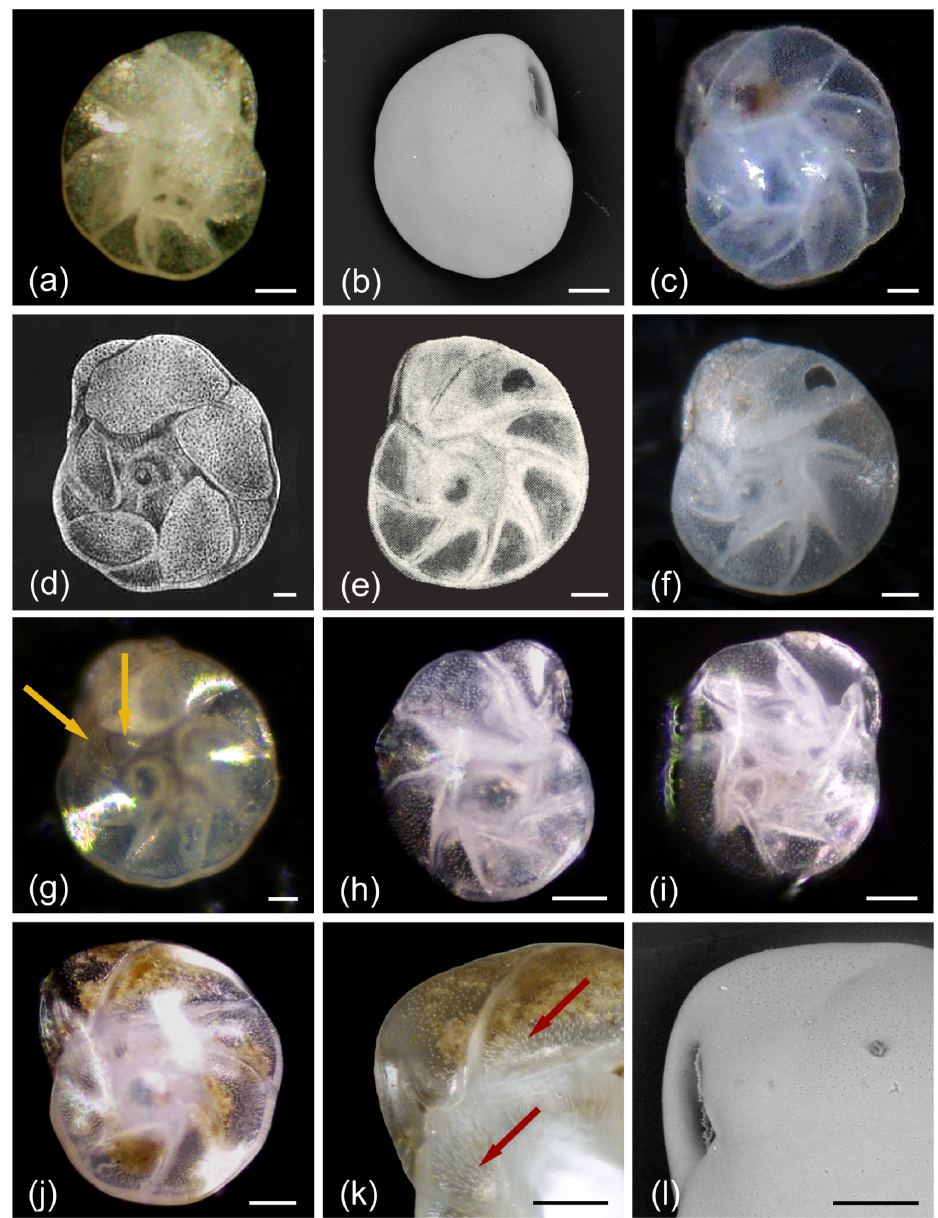
Figure 4. Islandiella helenae and Islandiella norcrossi . (a, c) Light microscope images and (b) SEM images of I. helenae ; note how easily these specimens may be mistaken for C. neoteretis if the apertural structure is overlooked. (d) Original holotype illustration of I. helenae . (e) Original holotype illustration of I. norcrossi and (f) its re-image. (g–k) Light microscope images and (l) SEM images of I. norcrossi . Notice the differences in proloculus size due to reproduction causing (h) megalospheric or (i) microspheric forms. (k) Close- up of pore tubules (shown by arrows) and the aperture of I. norcrossi in light microscopy. (l) Close-up of the aperture of I. norcrossi in SEM. (g) Light microscope image of I. norcrossi , showing a specimen that may potentially be misidentified as I. helenae were it not for the early triangular chambers (shown by arrows), which categorize it as an I. norcrossi All scale bars denote 50µm aside from (k–l) where they show 25µm. See Supplement Table S1 for sample details. The original holotype illustrations (d, e) are reproduced by permission from the Smithsonian Libraries. The re-image of the I. norcrossi holotype (f) is from the Paleobiology Collections of the Smithsonian National Museum of Natural History (https://collections.nmnh.si.edu/search/paleo/, last access: 3 March 2021) and made available under the Creative Commons CC0 1.0